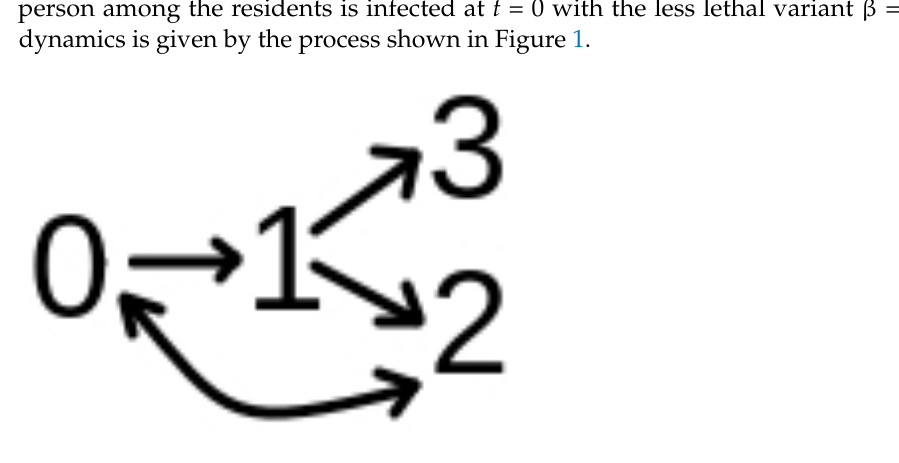
Figure 1. Schematic representation of transitions between states in our model. Probabilities are discussed in the text.